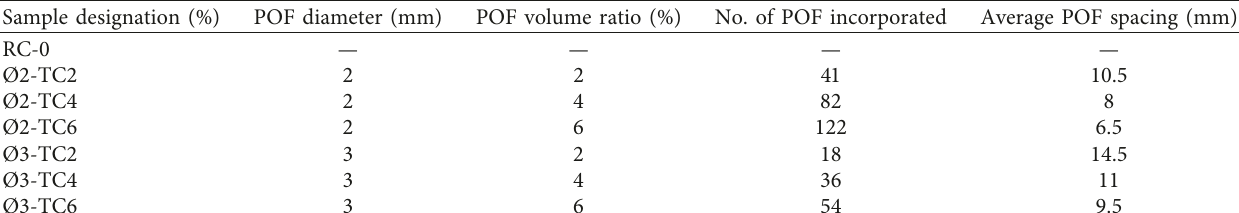
Table 5: Details of POF integrated on translucent concrete specimens for the flexural strength test.